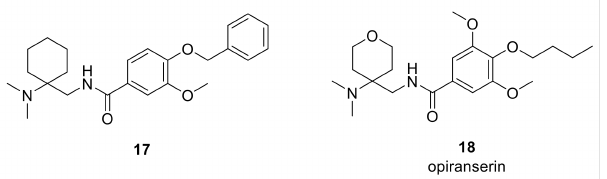
Figure 6. ORG25543-related GlyT2 inhibitors (17) and opiranserin